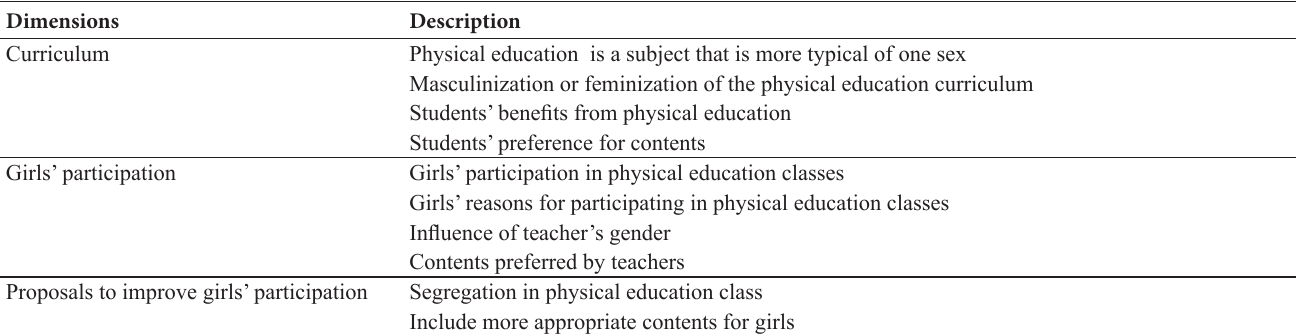
Table 1. Dimensions and description of each dimension for analysis of the interviews.